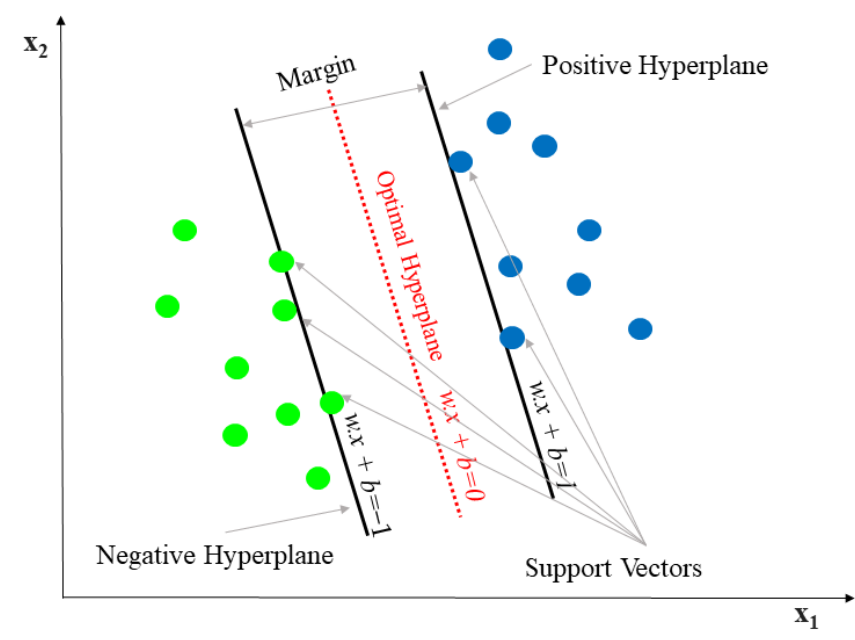
Figure 4. Representation of the SVM Margin.